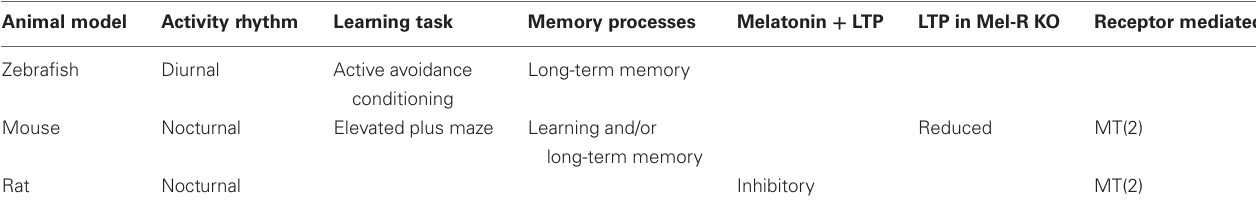
Table 1 | Influence of melatonin on memory performance and synaptic plasticity in diurnal and nocturnal species. Animal